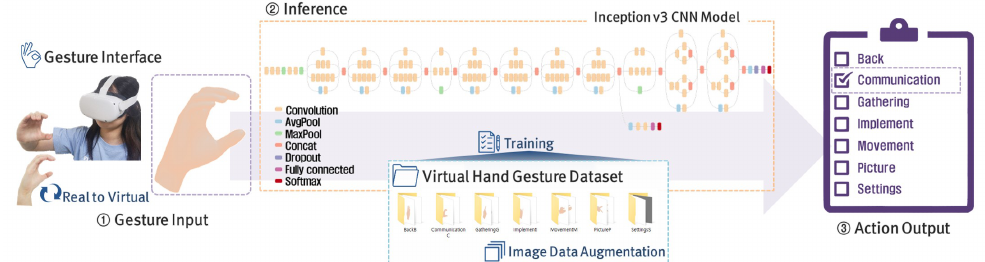
Figure 3. Deep learning model structure of the gesture interface and process of inferring mode transition